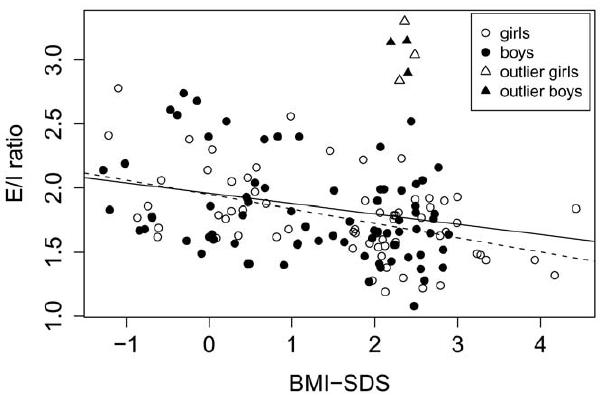
Figure 1. Correlation between E/I ratio (index of parasympa- thetic nervous system) and BMI-SDS in 149 normal-weight and obese children. The solid regression line is found using all the data points, whereas the dashed line is found upon eliminating the outliers marked as triangles. For all the data points, Pearson’s correlation coefficient= 2 0.24 (p=0.003) and without the outliers, it is 2 0.41 (p=3 6 10 2 7 ).